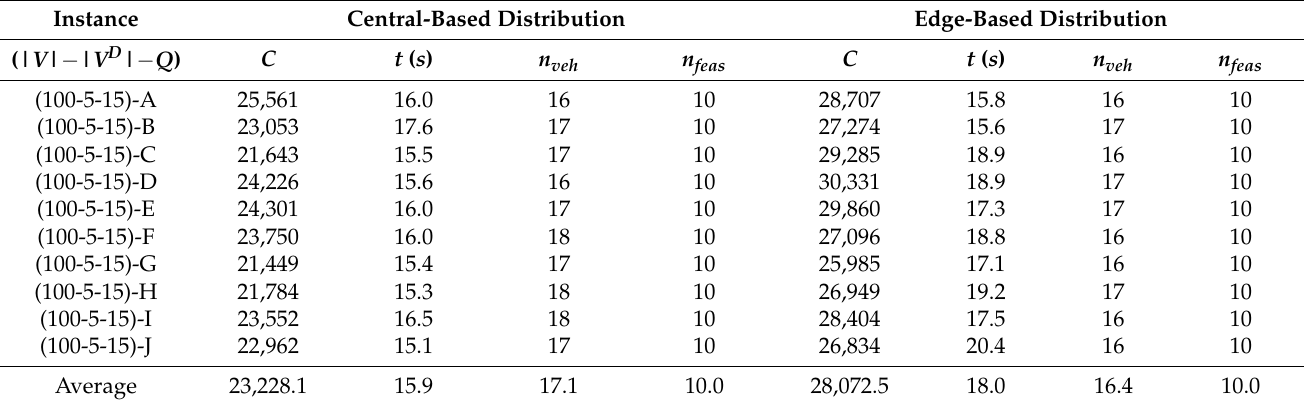
Figure 9. Central-based distribution and edge-based distribution of depots. Table 10. Comparison results of central-based distribution and edge-based distribution of depots.